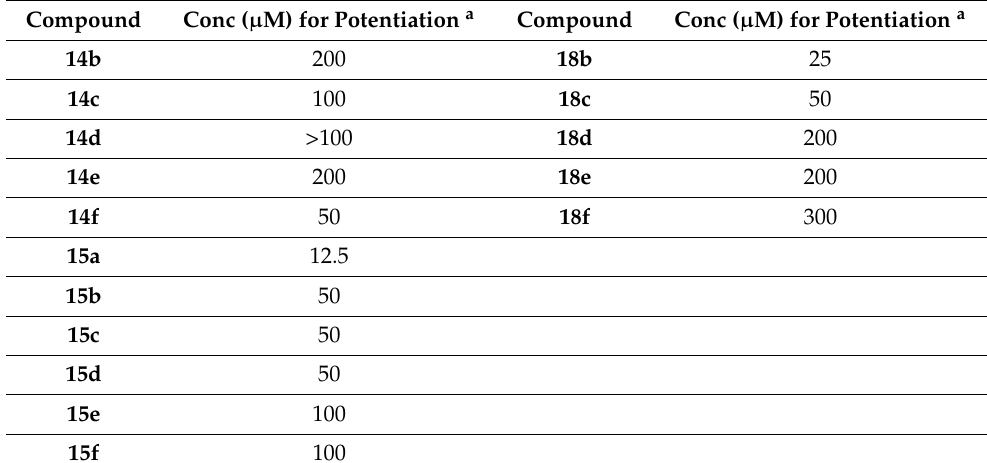
Table 3. Cont. Compound Conc ( µ M) for Potentiation